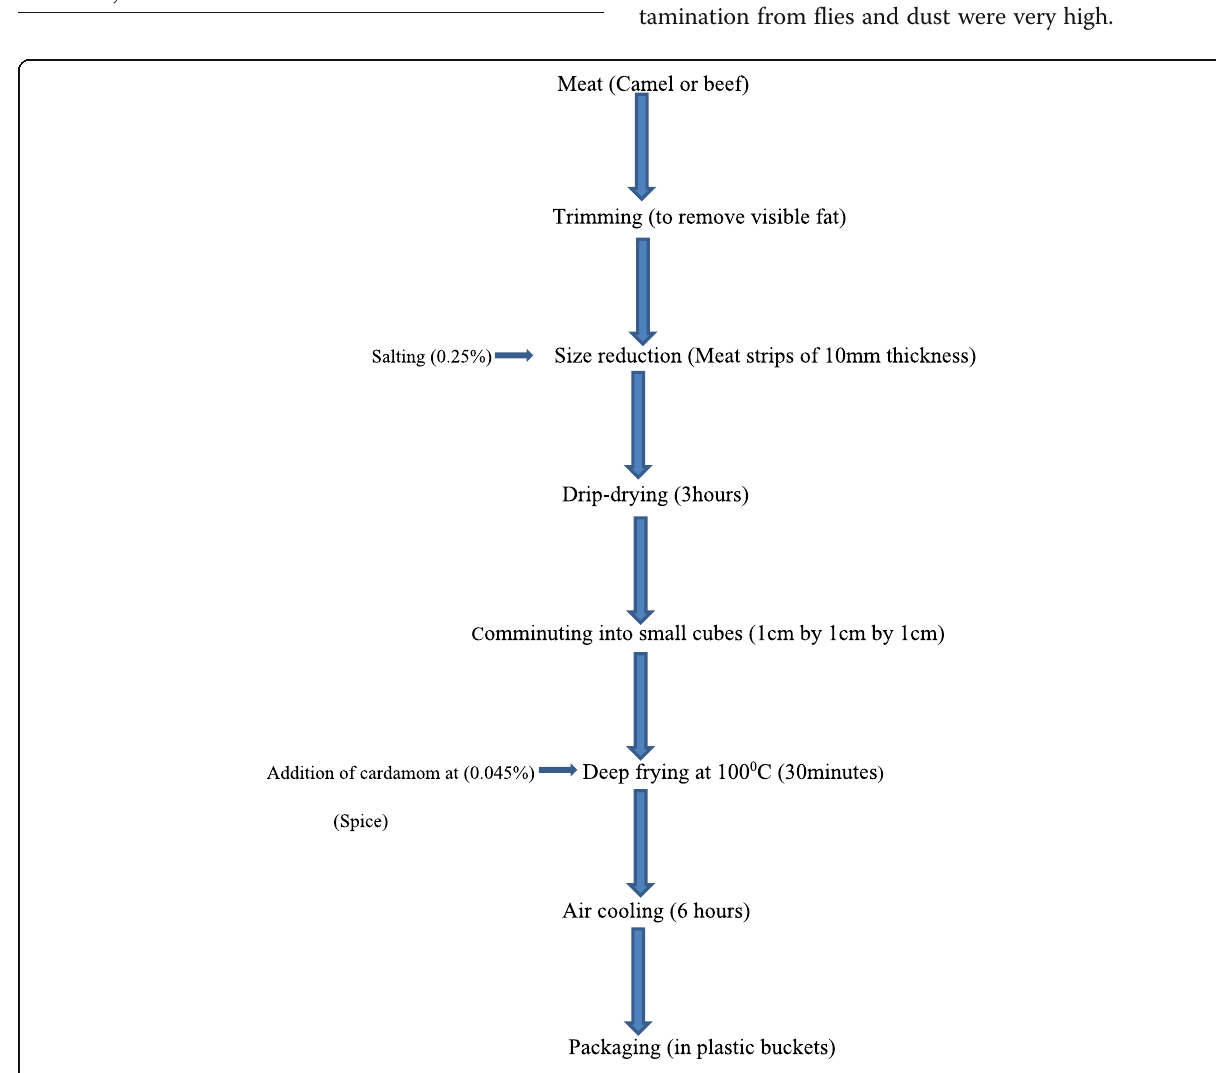
Fig. 2 Process analysis of koche , a traditional pastoral meat